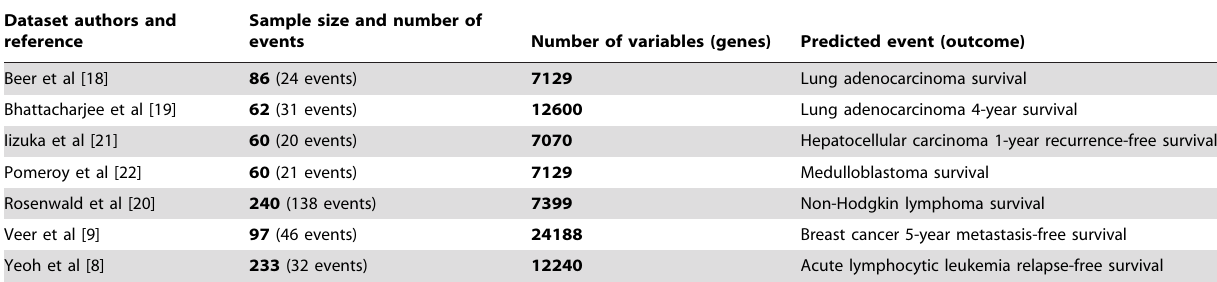
Dataset authors and